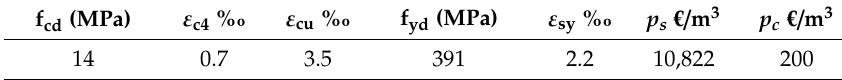
Figure 4. Reinforcement distributions: top reinforcements ( left ) and bottom reinforcements ( right ).